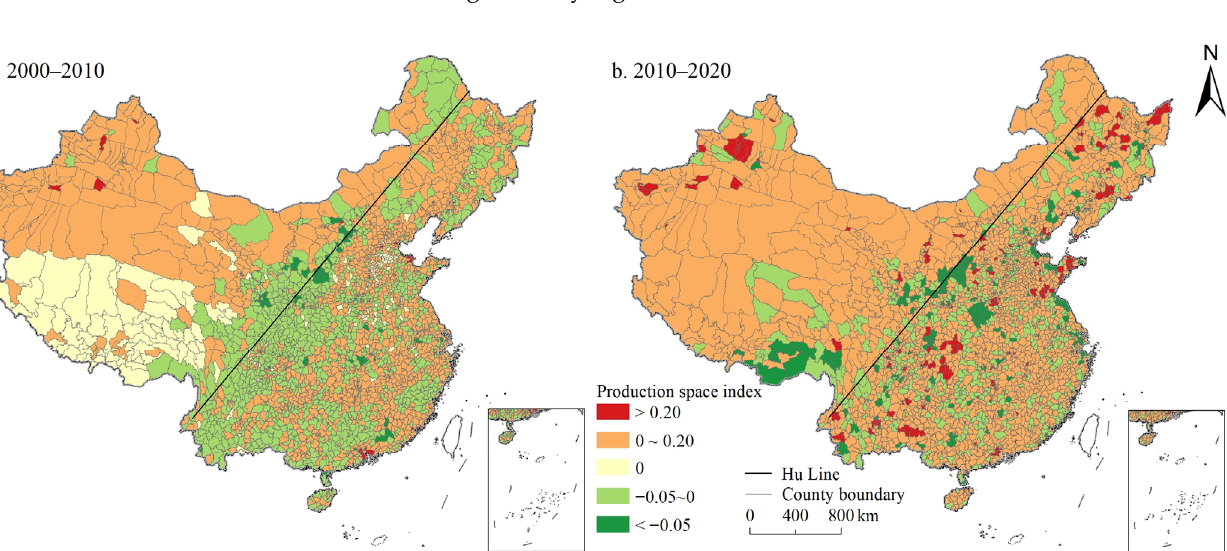
Figure 3. Spatial distribution of ESI changes in China during 2000–2020. 4.2. Gravity Centers of PLES Index in China from 2000 to 2020 Based on the gravity centers model, this study calculated the evolution law of gravity centers of the PLES index in 2000, 2010, and 2020, and generally found that the living space, production space, and ecological space had a trend of migration to western China during the study period (Figure 4). Specifically, the living space moved 34.241 km to southwest China from 2000 to 2010, and 28.382 km to northwest China from 2010 to 2020. Production space continued to migrate to northwest China during the study period, but the migration was not evident, with a migration of 1.204 km to southwest China from 2000 to 2010, and 9.257 km to northwest China from 2010 to 2020. The ecological space shifted 6.243 km to northwest China from 2000 to 2010, and 3.858 km to southeast China from 2010 to 2020.